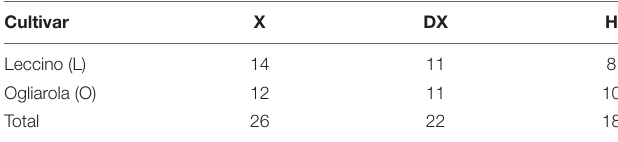
TABLE 1 | Summary of X, H, and X treated with Dentamet R (cid:13) samples. X denotes samples in which X. fastidiosa is present, H denotes samples in which X. fastidiosa is absent, DX indicates olive trees treated with Dentamet R (cid:13) in which X. fastidiosa is present. Cultivar X DX H Leccino